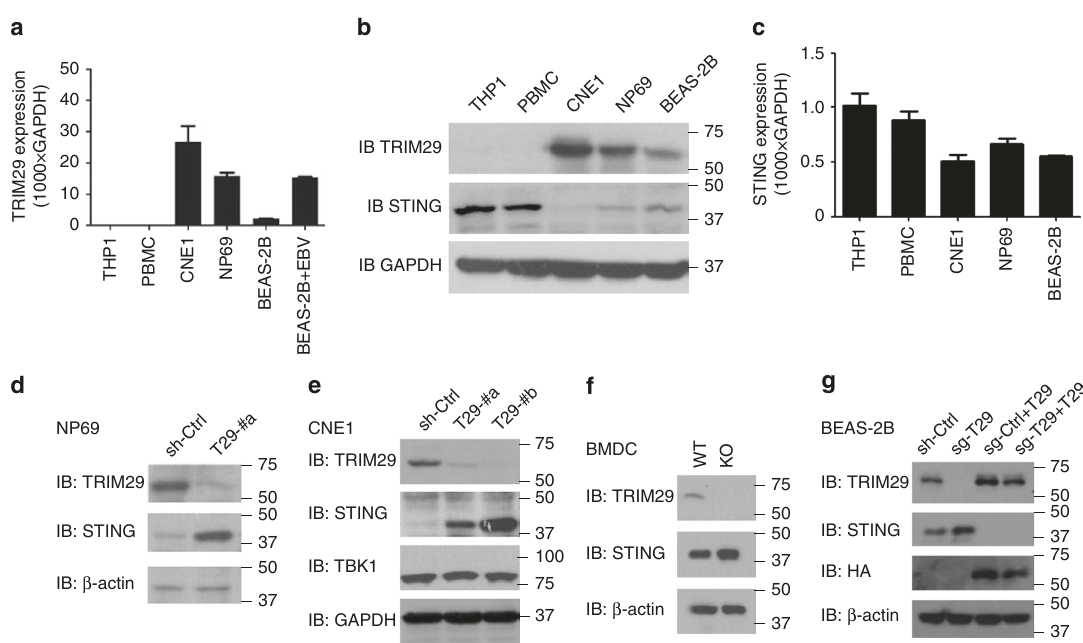
Fig. 5 TRIM29 inhibits the expression of STING. a Quanti fi cation of TRIM29 mRNA expression in human THP-1 cells, PBMCs, CNE1 cells, NP69 cells, BEAS-2B cells, and BEAS-2B cells with EBV infection at MOI of 5. b Immunoblot analysis of TRIM29 and STING expression in human THP-1 cells, PBMC, CNE1 cells, NP69 cells, and BEAS-2B cells. c Quanti fi cation of STING mRNA expression in human THP-1 cells, PBMCs, CNE1 cells, NP69 cells, and BEAS-2B cells. d – f Immunoblot analysis of TRIM29, STING, and TBK1 expression in human healthy NP69 cells d , human NPC cell line CNE1 cells e treated with control shRNA with scrambled sequence (sh-Ctrl), shRNA targeting mRNA encoding TRIM29 (two shRNAs: T29-#a and T29-#b), or BMDCs f isolated from WT and Trim29 − / − KO mice. g Immunoblot analysis of TRIM29 and STING expression in human bronchial epithelial BEAS-2B cells treated by CRISPR vector control (sg-Ctrl) or sgRNA targeting 5 ′ UTR region of TRIM29 (sg-T29) with or without overexpression of HA-tagged TRIM29. GAPDH and β -actin serve as loading control. The position of protein markers (shown in kDa) is indicated on the right . Data are representative of three experiments (mean and SD of three samples in a , c Lys137, Lys150, Lys224, Lys236, Lys347, and Lys370) were